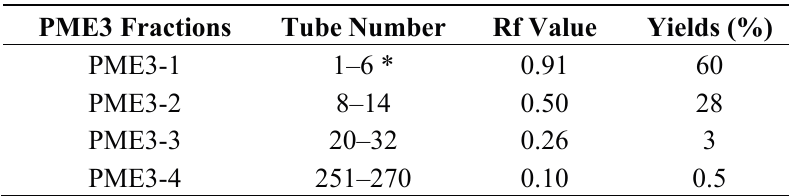
n -hexane:ethyl acetate =